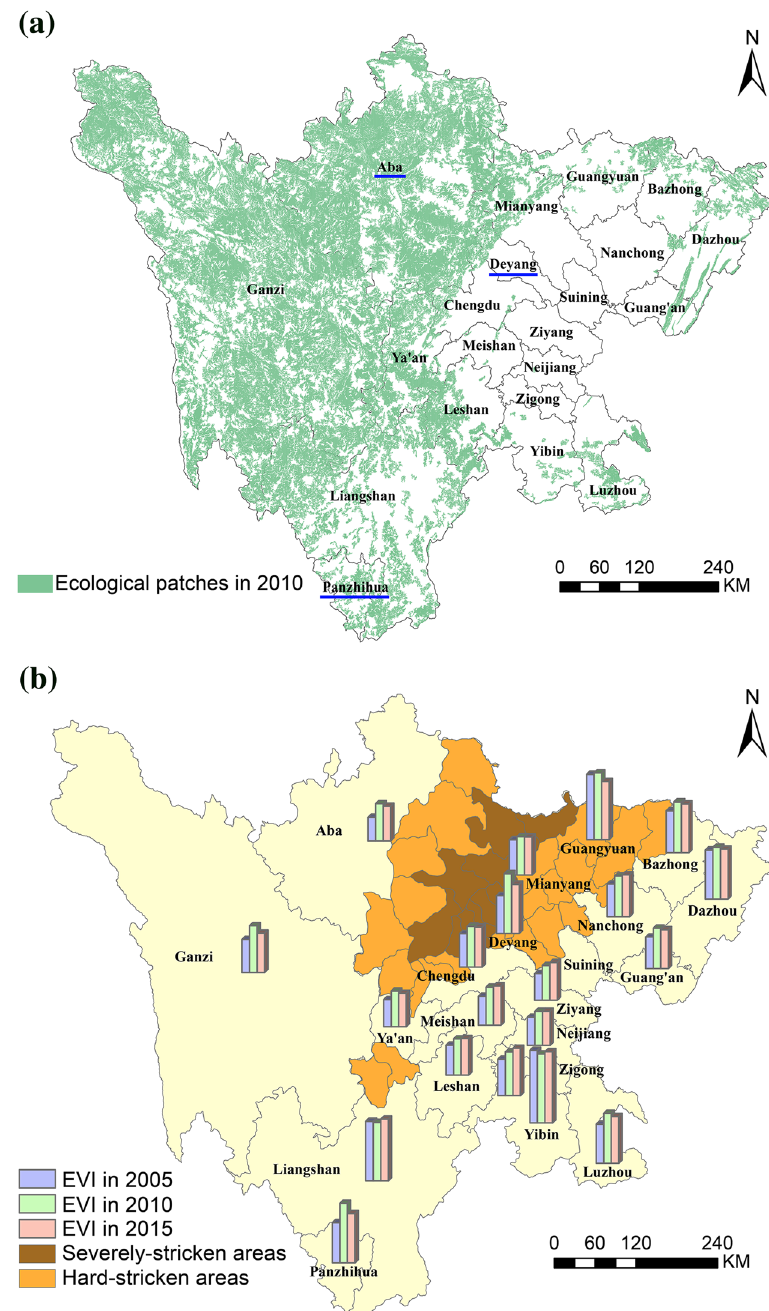
Fig. 2 Distribution of ecological patches and ecological vulnerability index (EVI) values in Sichuan Province. a The spatial distribution of ecological patches in 2010; b the distribution of EVI values in 2005, 2010, and 2015. The severely-stricken areas and the hard-stricken areas are short for severely-stricken areas of the Wenchuan Earthquake and hard-stricken areas of the Wenchuan Earthquake, which are provided by the Ministry of Civil Affairs of